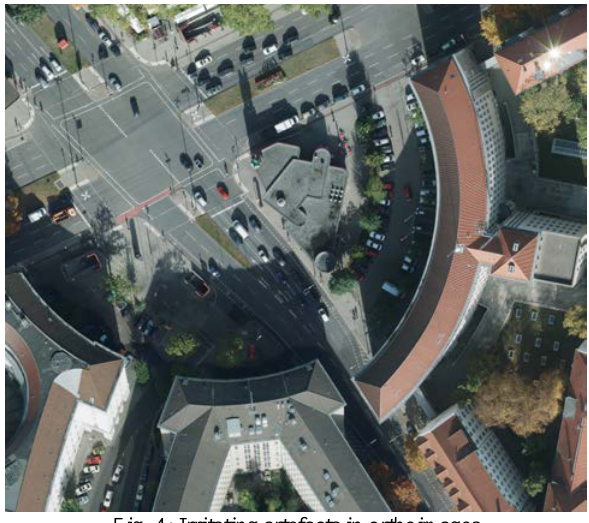
Fig. 4: Irritating artefacts in